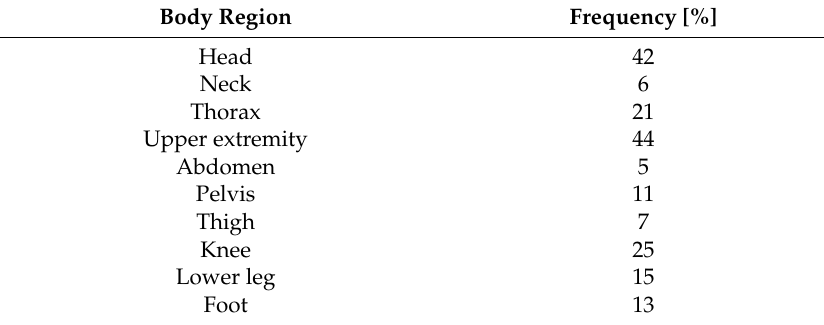
Table 1. Injury frequency of cyclist’s body region, adapted from [4,29].